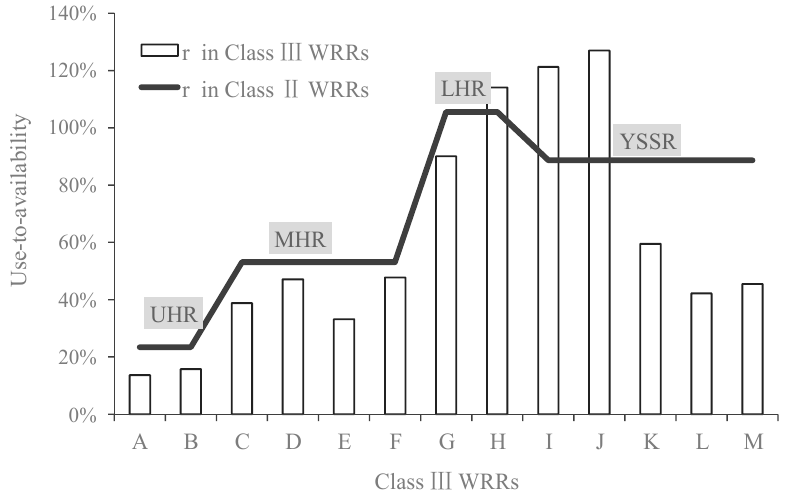
Figure 5. Water consumption rates and water resource quantities of the Huai River Basin at the Class II WRR scale and Class III WRR scales. The names of Class III WRRs are the same as those given in Figure 4.